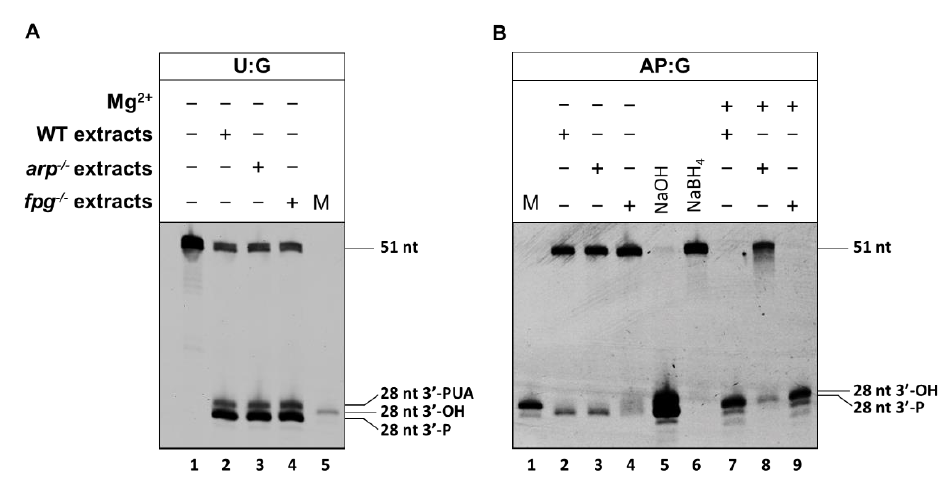
Figure 3. Incision assay for characterization of Arabidopsis WT, arp −/− and fpg −/− cell extracts. ( A ) Uracil DNA glycosylase activity. Cell extracts from WT, arp −/− and fpg −/− lines (25 µg) were incubated for 3 h at 37 °C in the presence of 20 nM of DNA substrate containing an uracil. Reaction products were separated by denaturing PAGE and detected by fluorescence scanning. M, 28 size marker with 3′-OH. ( B ) AP lyase and AP endonuclease activity. WT, arp −/− and fpg −/− cell extracts (25 µg) were incubated for 3 h at 37 °C in the presence of 20 nM of DNA substrate containing an AP site opposite G, either in the presence or in the absence of 2 mM Mg 2+ . After stabilization with NaBH 4 , reaction products were separated and detected as indicated above.